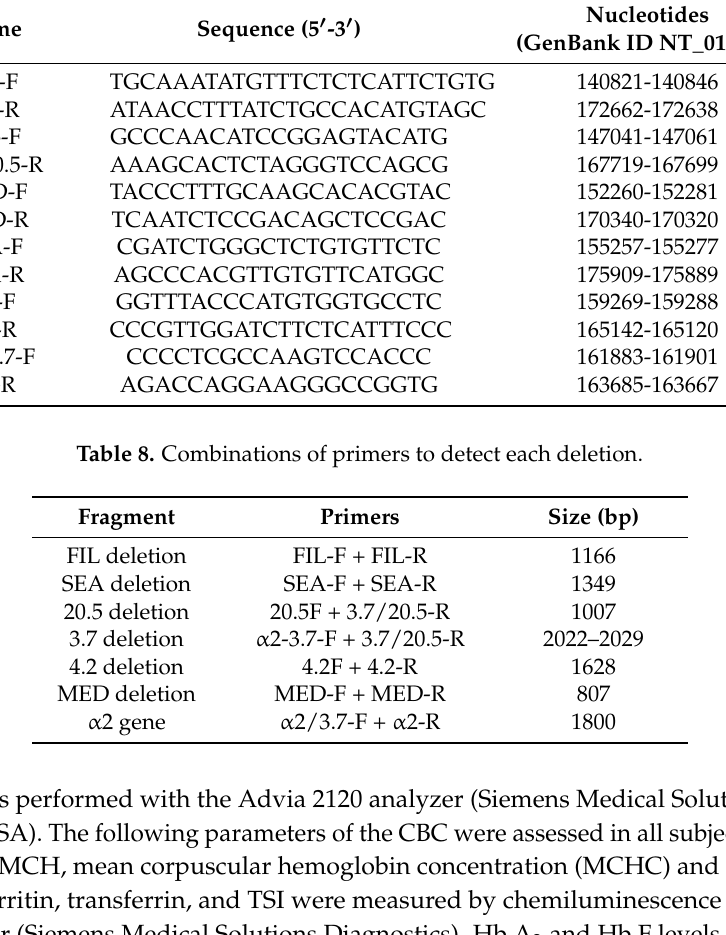
Table 7. Primers for PCR analysis of common α -thalassemia deletions.